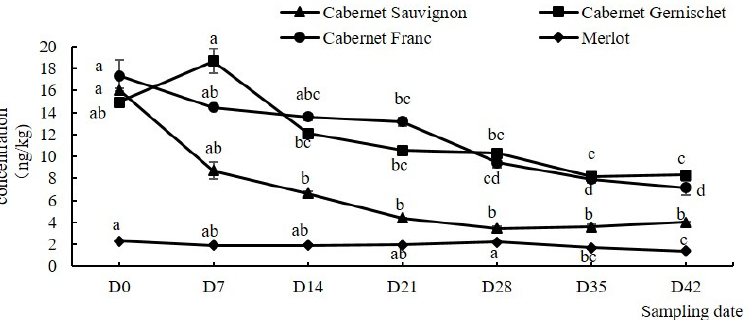
Figure 4. Changes of IBMP during grape ripening. (The ordinate represents the content of IBMP, and the abscissa represents the sampling date explained above.).